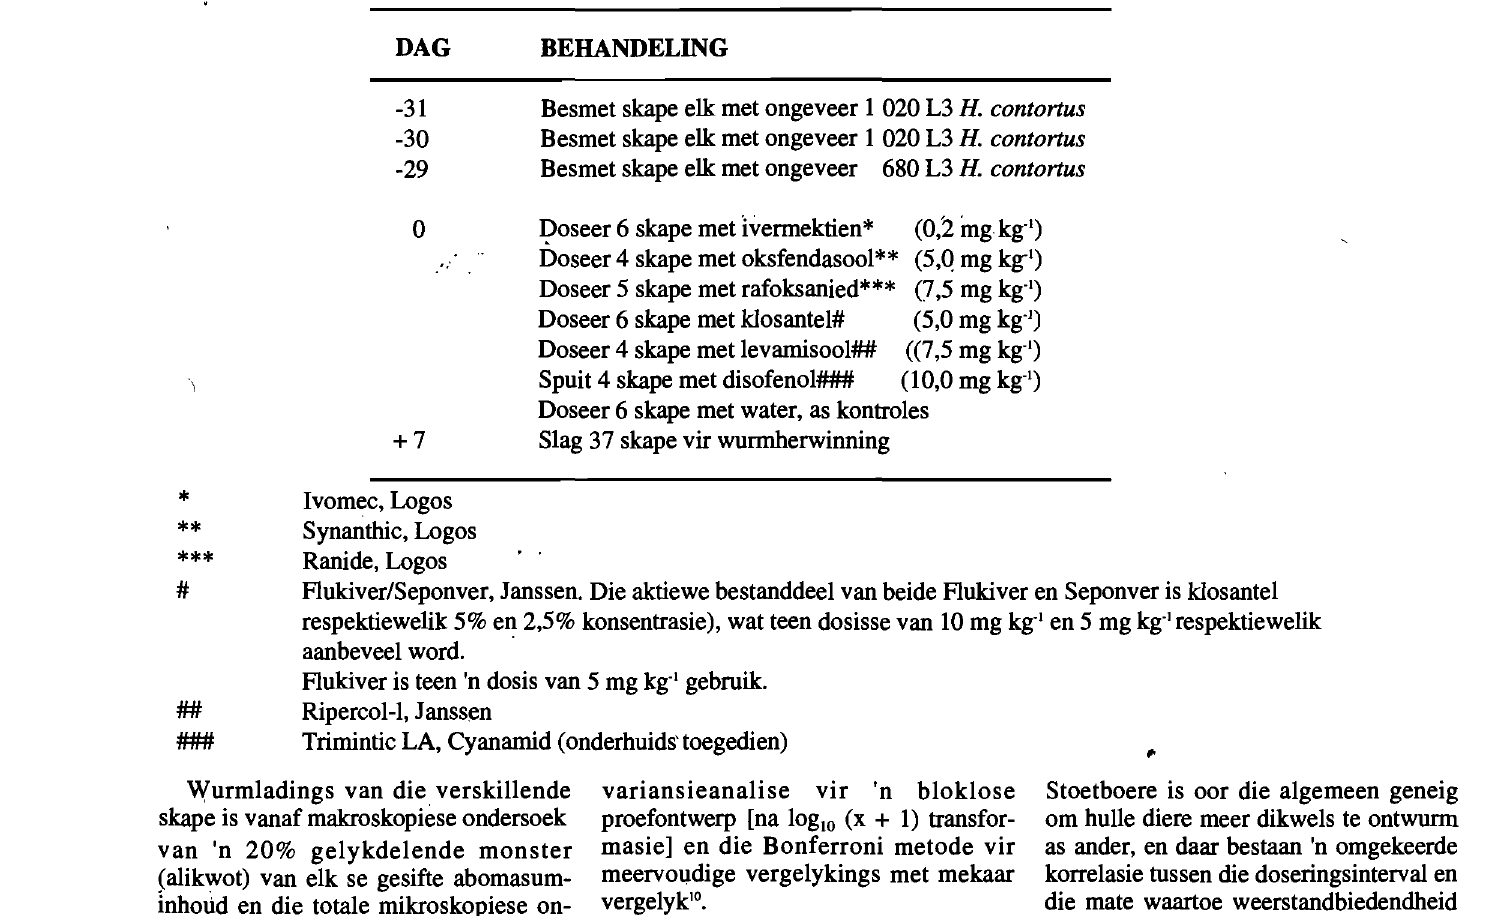
Tabel1: Besmetting van skape met Haemonchus con/onus en daaropvolgende behandeling met verskillende